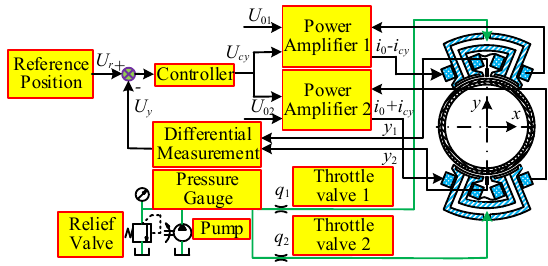
Figure 4. Single DOF control system of MLDSB.